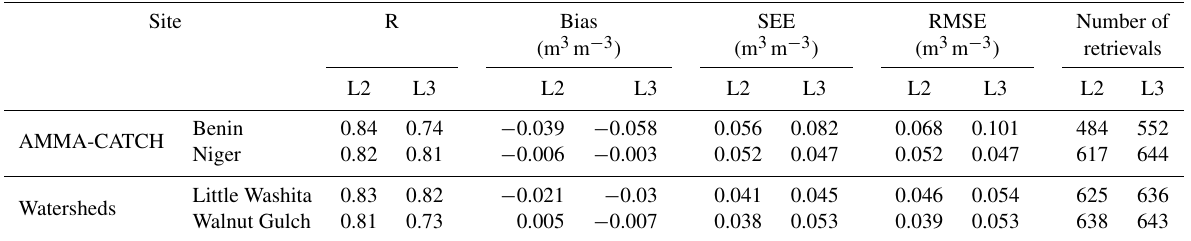
Table 6. Statistics of the in situ vs. SMOS L3SM and L2SM for ascending orbits.